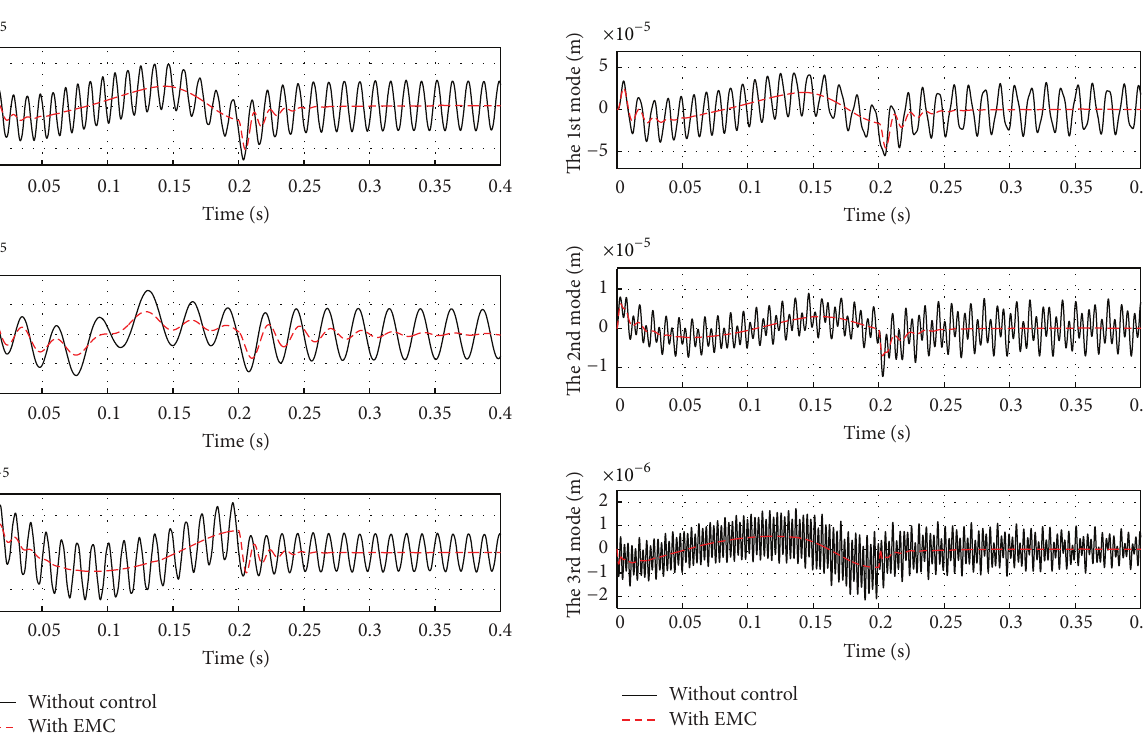
on the location of quarter, midpoint, and three quarters